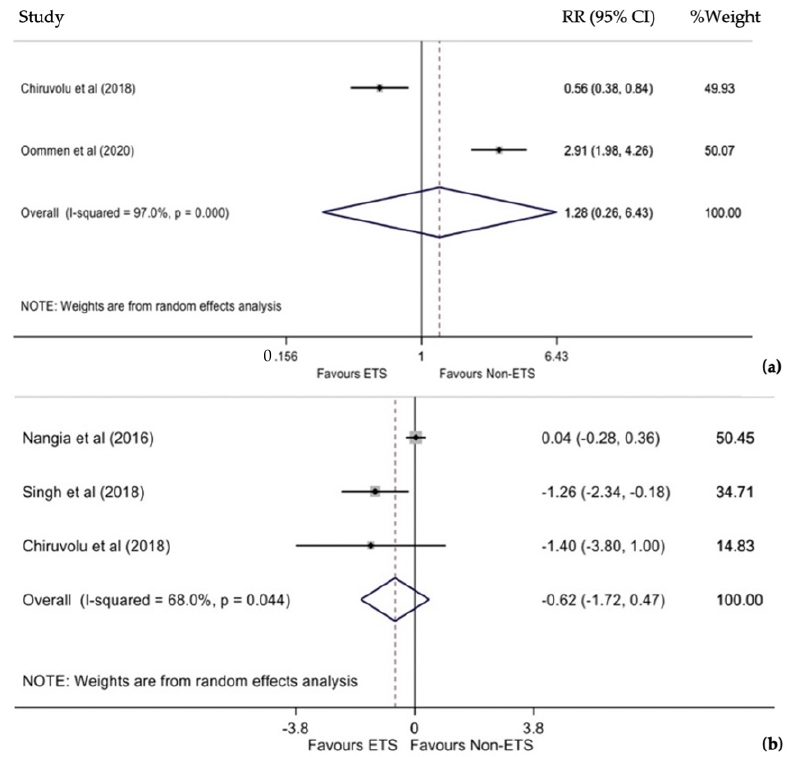
Figure 5. ( a ) Forest plot of RR for admission to NICU between ETS and non-ETS. ( b ) Forest plot of mean difference in duration of hospitalization ETS and non-ETS.